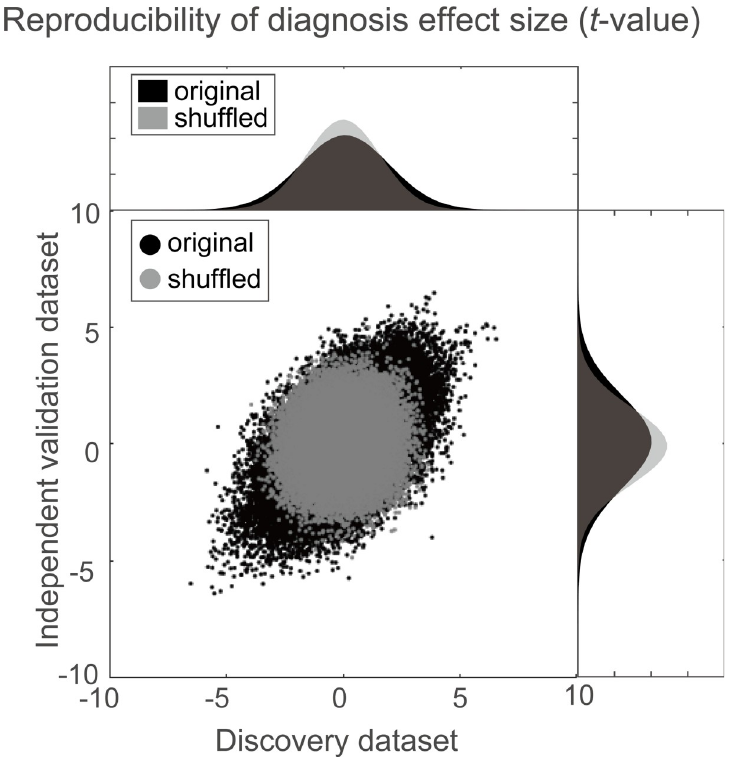
Fig 1. Results of mass univariate analysis. Reproducibility across the 2 datasets regarding diagnosis effects. Scatter plot and histograms of the diagnosis effect size (the difference in mean functional connectivity strengths between patients with depression and healthy groups: t -value). Each point in the scatter plot represents the diagnosis effect in the discovery dataset in the abscissa and that for the independent validation dataset in the ordinate for each functional connectivity. The original data is in black, while the shuffled data in which subject information was permuted is in gray. The numerical data used in this figure are included in S1 Data.